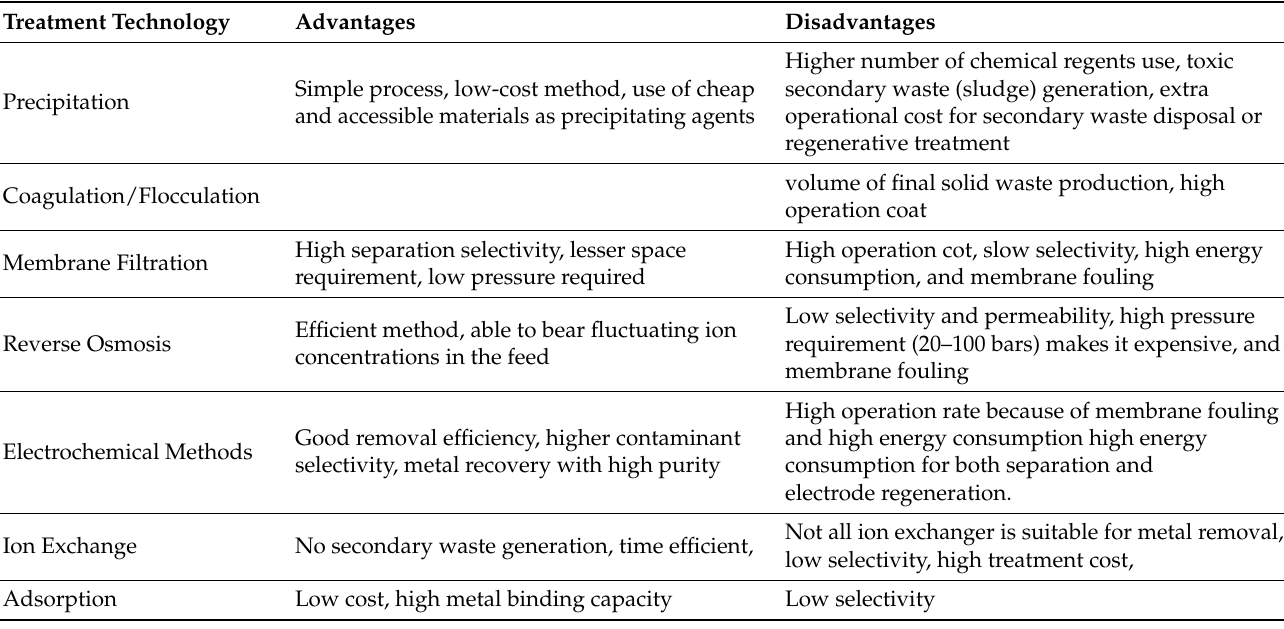
Table 2. The available treatment technologies for heavy metals and their comparison with membrane filtration [15,23,86,110]. Treatment